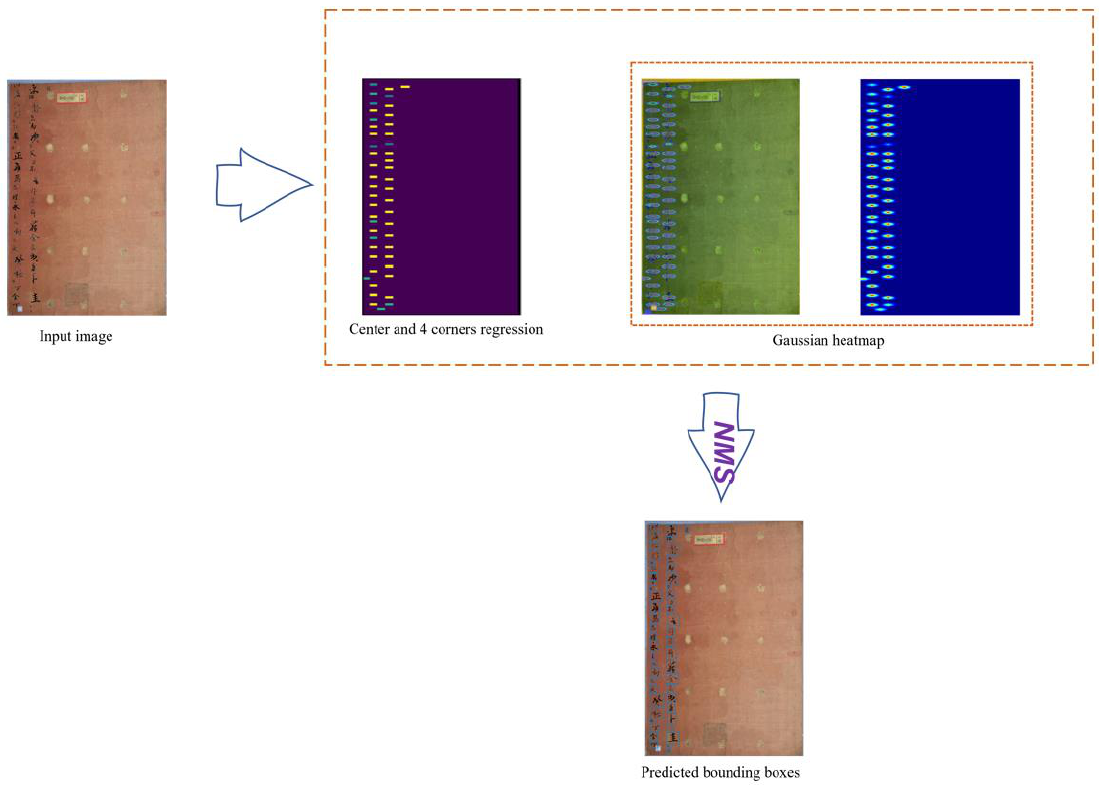
Figure 3. Illustration of automatically finding character centers and building bounding boxes from bounding box annotations, clarifying positives and negatives. From left to right, the input image already has box annotations that are generally obtained by algorithms using default boxes for predictions. Then, a center heatmap with regression to the four bounding box corners indicates all centers as positives. Otherwise, they are negative. Finally, to eliminate the fuzziness of these negatives fencing the positives, Gaussian normalization, presented in equation 2, is presented in the third and fourth images on the right. The output prediction is adopted after Non-Maximum Suppression (NMS).